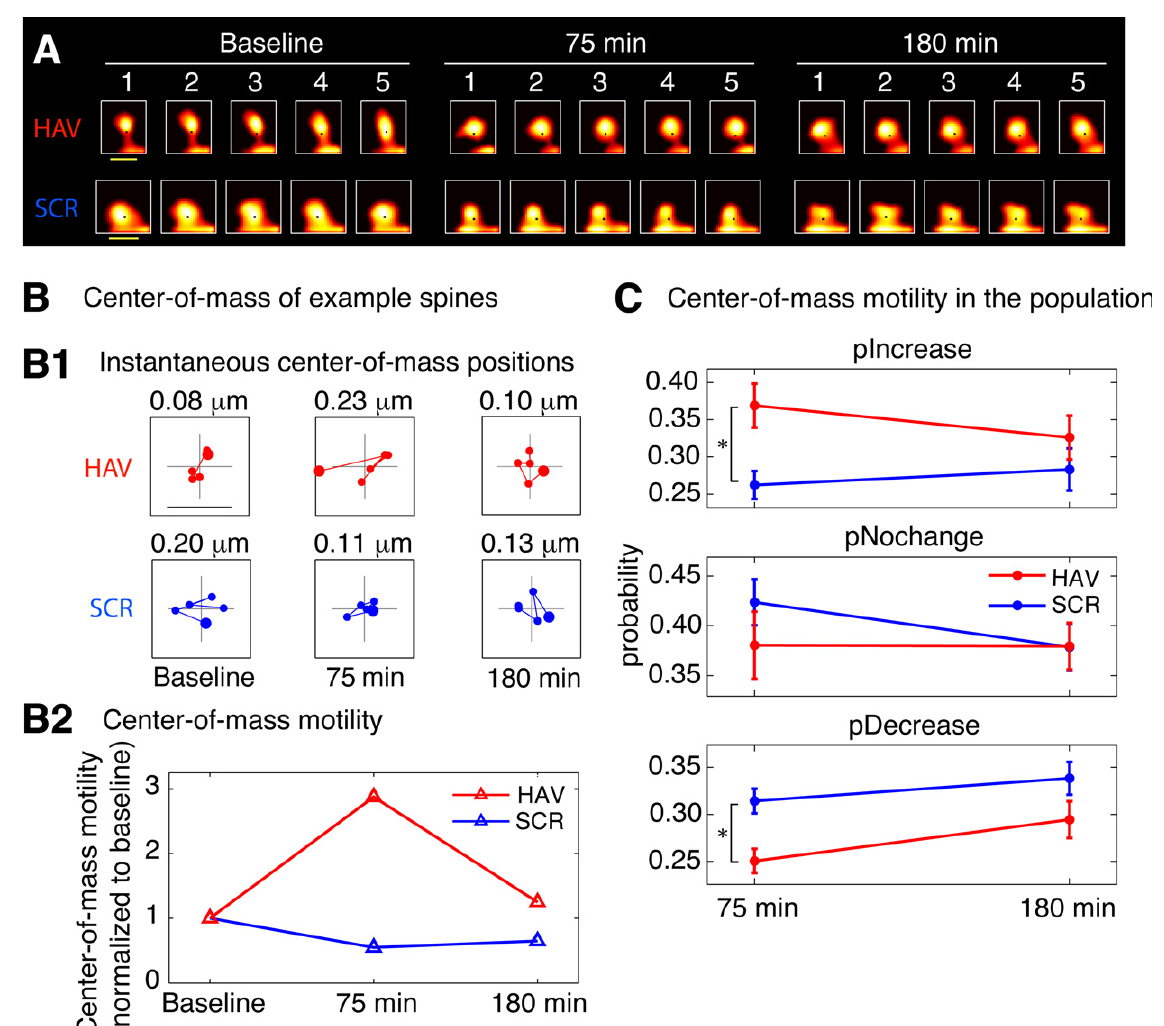
Figure 4. Spines show an increase in center-of-mass motility (fast timescale dynamics) after surface N-cadherin disruption. (A) Time-lapse images of representative persistent spines from AHAVD (HAV) and AADHV (SCR) treated neurons acquired at baseline, 75 minutes after treatment, and 180 minutes after treatment. The black dot superposed on each image represents the center-of-mass of the spine at that instant as computed from the thresholded image (see Materials and methods section). Scale bar = 1 μ m. (B) Center-of-mass calculations for the example spines shown in A. (B1) Each panel shows the locus of successive instantaneous center-of-mass positions over the 5 minutes within a time-point (after translational normalization to center the locus at the origin). The large fi lled circle represents the position of the spine at the fi rst minute within that time-point. The locus in each panel gives a visual indication of the extent to which the spine is motile. The center-of-mass motility value (net movement) of the spine within a time-point is indicated above the panel. Scale bar = 0.1 μ m and applies to all panels. (B2) Center-of-mass motility of the example spines is plotted normalized to baseline. There was no signifi cant difference at the baseline time-point in the center-of-mass motility values between the HAV- and SCR-treated spine populations. (C) Summary data (mean ± s.e.m) showing the probabilities of increase (pIncrease), no change (pNochange), and decrease (pDecrease) in the center-of-mass motility of all persistent spines. The motility value of a spine at each time-point was compared to that at baseline to determine the nature of change. Spine data in this and subsequent fi gures are based on 690 spines from HAV-treated cells, and 803 spines from SCR-treated cells (see Materials and methods section for